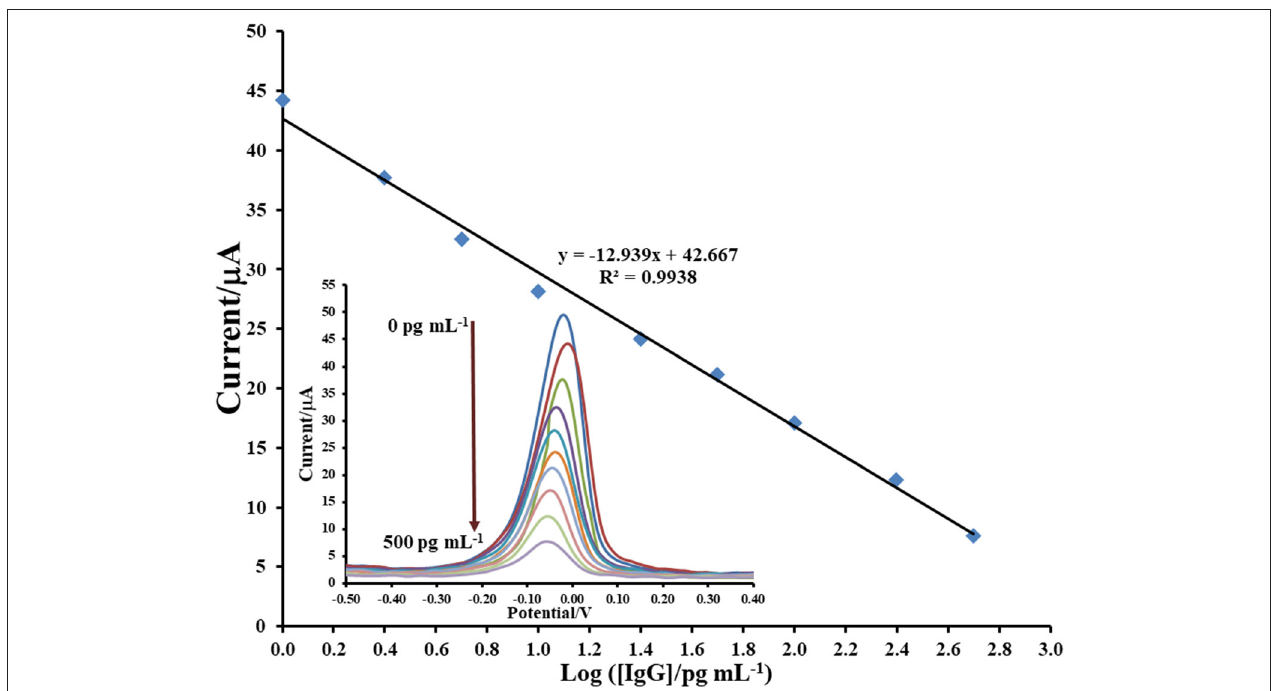
FIGURE 6 | Sensograms and corresponding calibration curve for label-free immunosensing of human IgG using Cu(II)/GO-modified